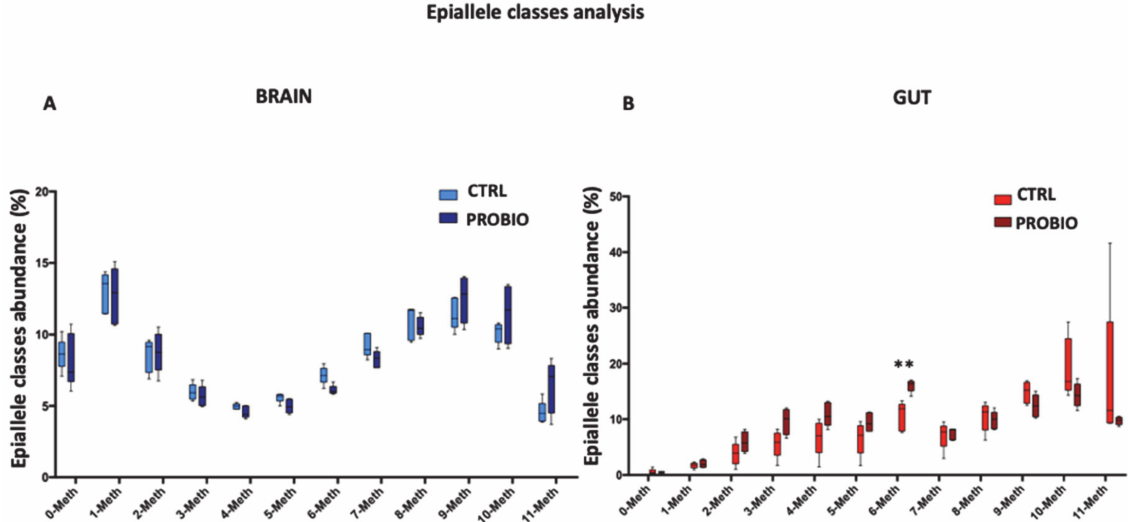
Figure 5. Epiallele classes distribution at the Tph1A promoter region in the gut and brain of CTRL and PROBIO groups. Boxplots show the relative abundance of different epiallelic classes (from 0 to 11 methyl-cytosine per molecule) in CTRL and PROBIO group and in ( A ) brain and ( B ) gut. Statistical analysis was performed using Multiple t -tests without correction. (** p ≤